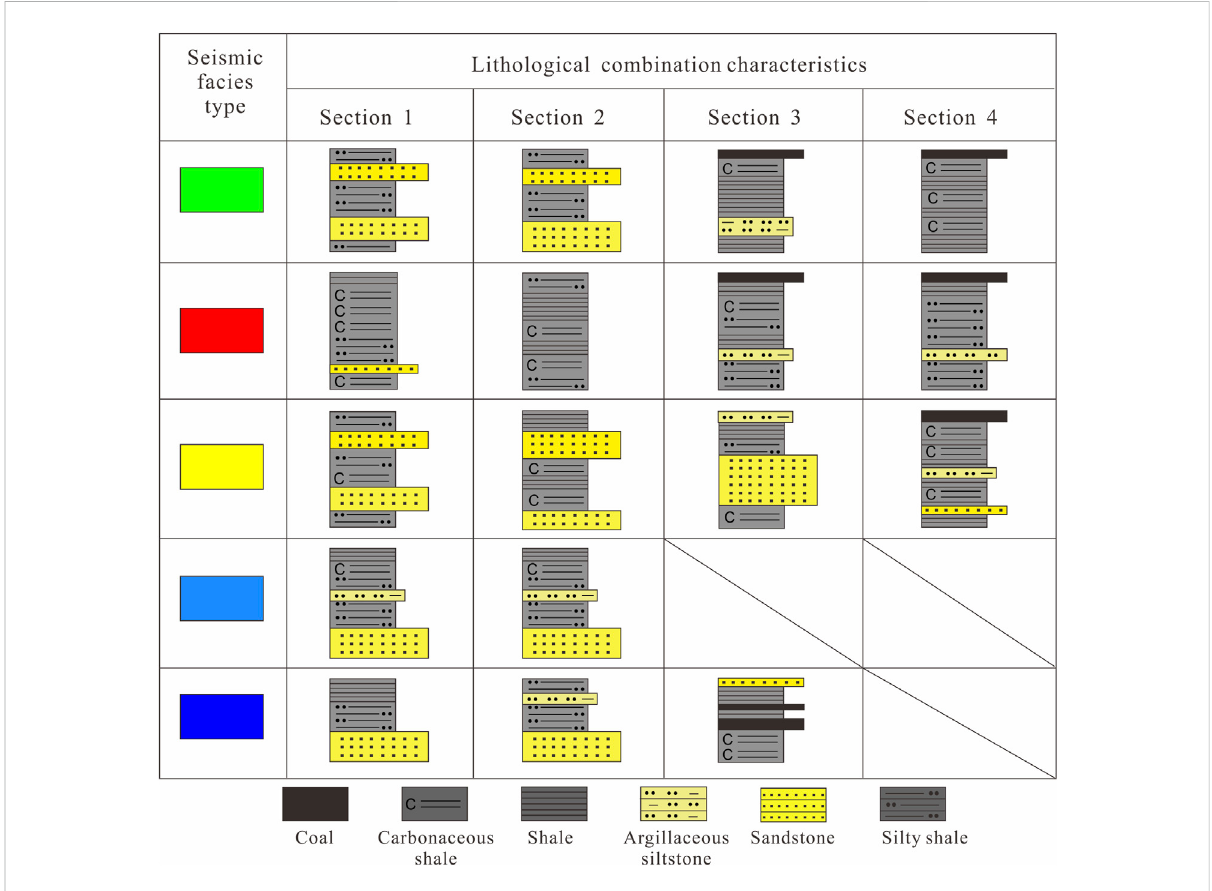
FIGURE 13 Lithological characteristics of different seismic facies types in the Shan-2 Lower